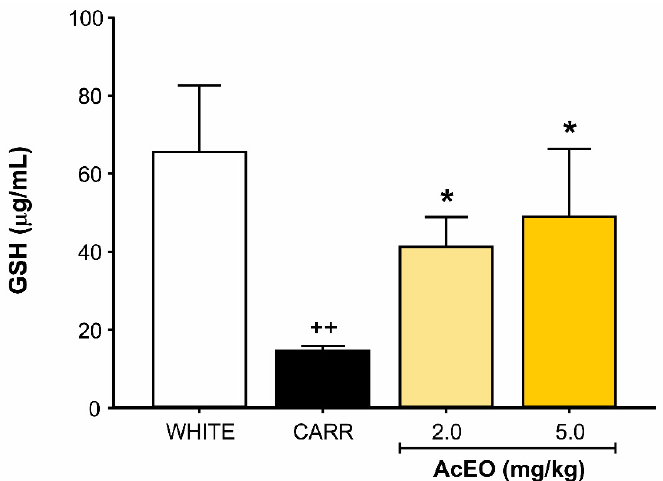
Figure 4. Effect of Aniba canelilla essential oil (AcEO; 2.0 and 5.0 mg/kg; ip.) on peritoneal fluid GSH concentration of rats submitted to carrageenan (CARR)-induced (0.3 mg/kg) peritonitis. Data expressed as mean ± SEM ( n = 5–6/group). ++ p < 0.01 vs. white group; * p < 0.05 vs. CARR group. Kruskal–Wallis followed by Dunn’s test.